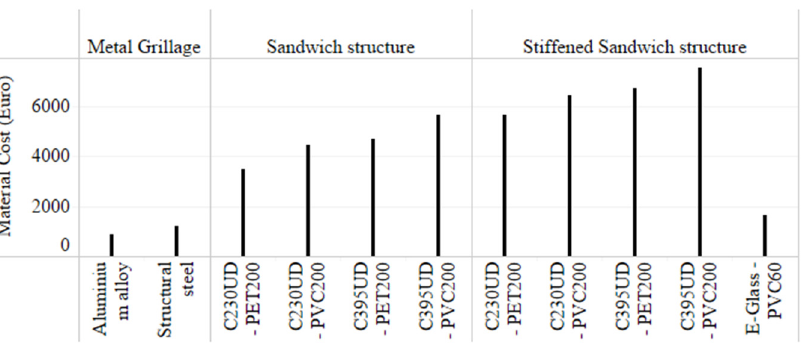
Figure 22. Cost comparison of structural concepts. (The material cost data is sourced from Ansys Granta [32]).